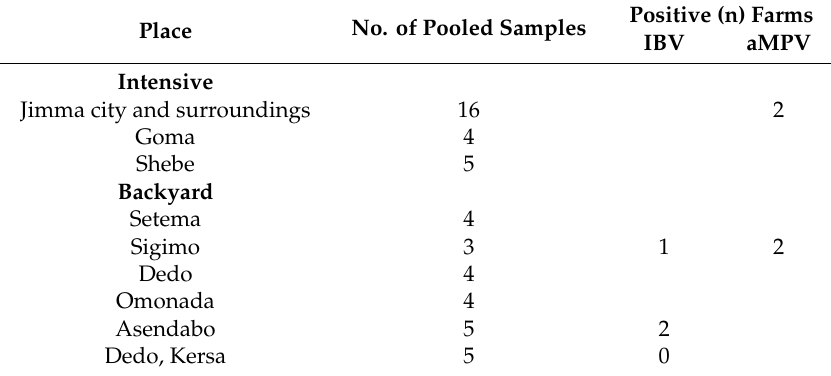
Table 1. Number of pooled samples collected, IBV and aMPV positive, classified according to sample location and production type.